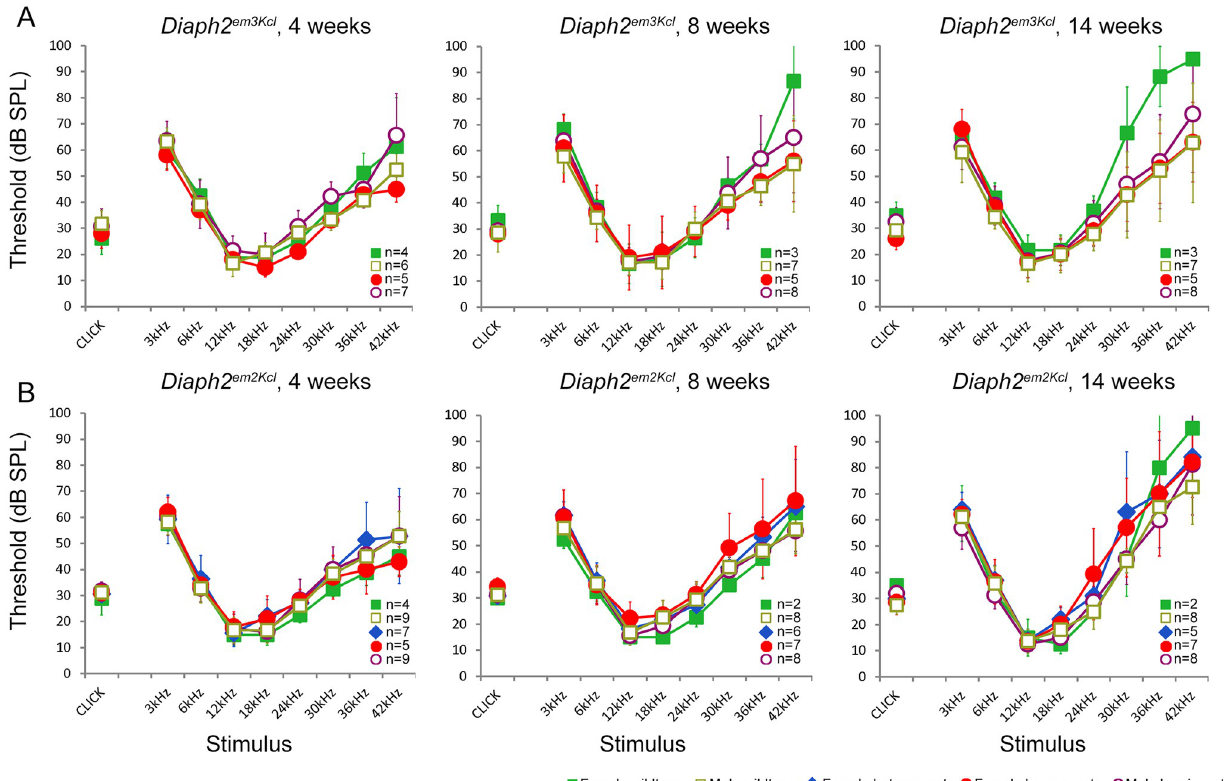
Fig 6. Analysis of auditory function in Diaph2 mutant mice. ( A ) Mean ABR thresholds of mice carrying the knock-in variant ( Diaph2 em3Kcl ) and ( B ) the knock-in variant plus a 19bp deletion ( Diaph2 em2Kcl ) at 4 (left), 8 (center) and 14 (right) weeks of age. Male hemizygotes (empty maroon circles) and female homozygotes (filled red circles) have thresholds comparable to female heterozygotes (filled blue diamonds) and male and female wildtypes (squares, female filled green, male empty gold) at all ages. At 14 weeks old the Diaph2 em3Kcl female wildtypes have raised high-frequency thresholds compared to the other genotypes, but since there are only three of them and the seven male wildtypes have normal hearing, we suggest that this is not a relevant biological difference. Numbers of each genotype tested are shown on each plot. Error bars show standard deviation.